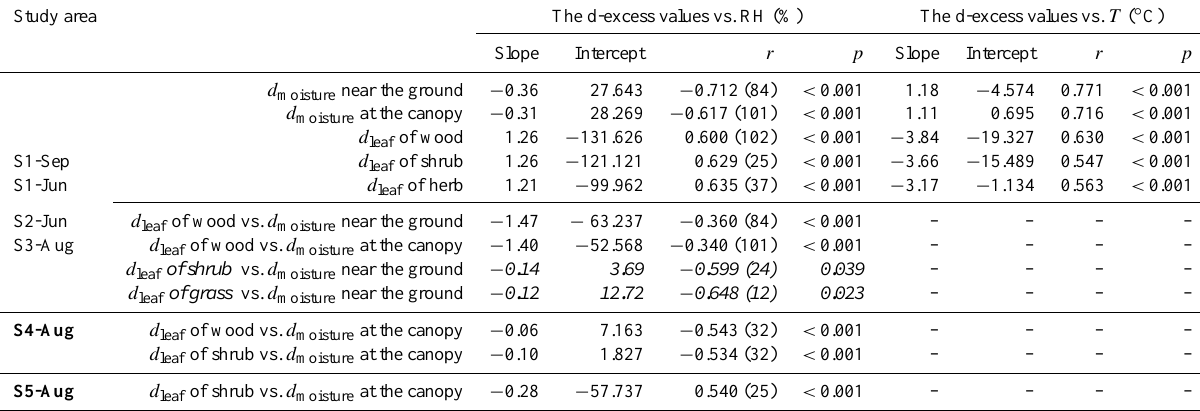
Table 7. Correlations between the d-excess of various water bodies and RH (%) and T ( ◦ C), and between d moisture and d leaf during the sunny days at each site. Here, r is the correlation coefficient, and p is the significance level. p < 0.001 indicates statistical significance at the 99.9% significance level, and p < 0.05 indicates statistical significance at the 95% significance level. The location ID and the abbreviations of plant Latin names are the same as in Tables 2 and 3. The periods of the sunny days are the same as in Fig.